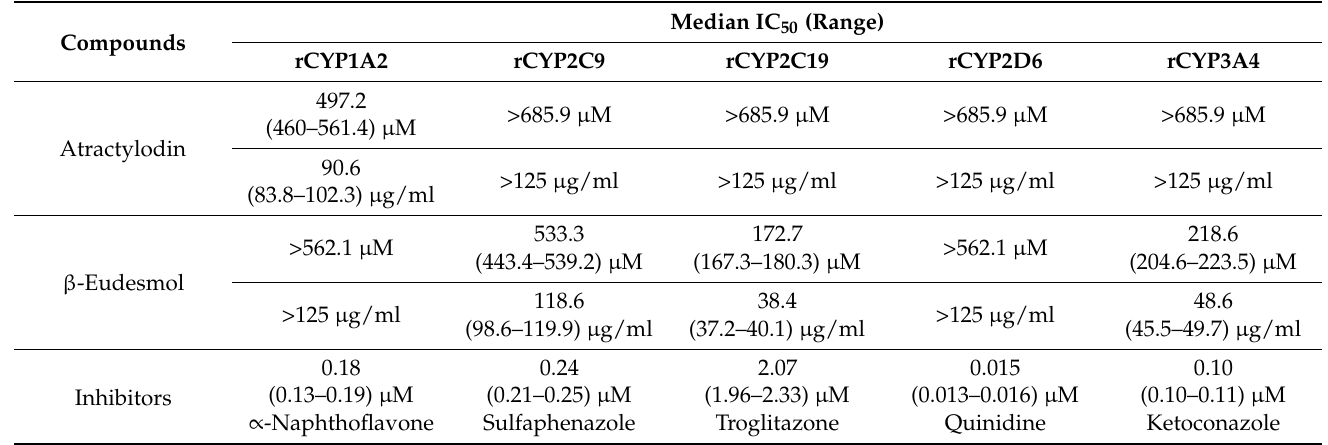
Table 1. The IC 50 values of atractylodin, β -eudesmol and the selective inhibitors on the five major human CYP450s (rCYP1A2, rCYP2C9, rCYP2C19, rCYP2D6, and rCYP3A4) enzymes. Data are presented as median (range) values from three independent experiments (triplicate